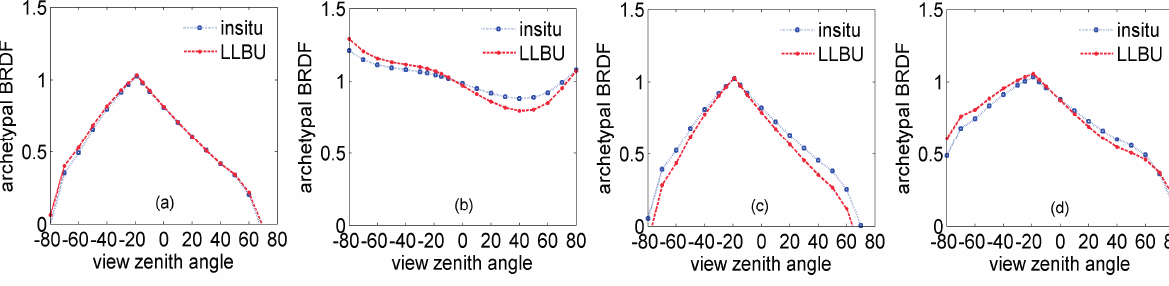
Figure 7. The BRDF shapes in the principal planes retrieved by the in situ measurements and the LLBU. ( a ) Band 1; ( b ) Band 2; ( c ) Band 3 ( d ) Band 4. The sun zenith angle in these planes is 19.01°; positive (negative) view zenith angles refer to forward (backward)